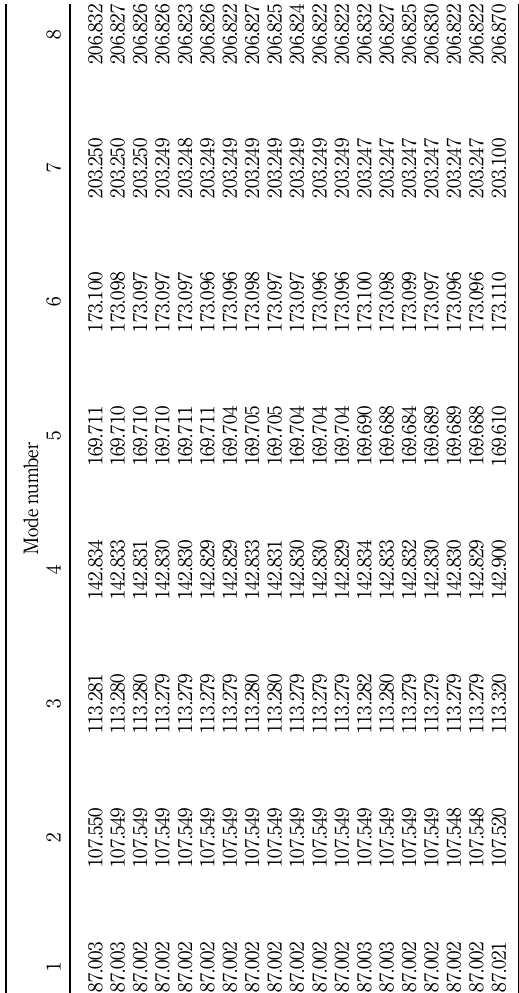
Table 5. Analysis of natural frequency convergence of the rotary composite laminated plate and conical – cylindrical double cavities coupled